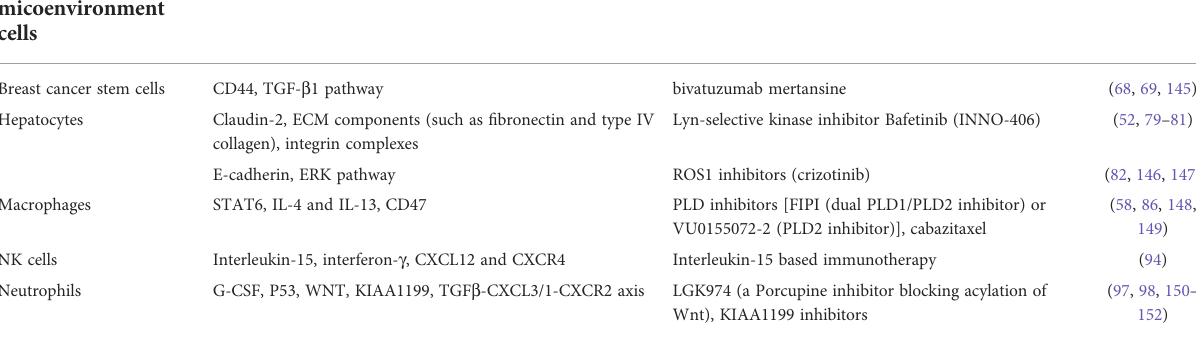
TABLE 3 Hepatic microenvironment related therapeutic implications in breast cancer liver metastasis. Hepatic